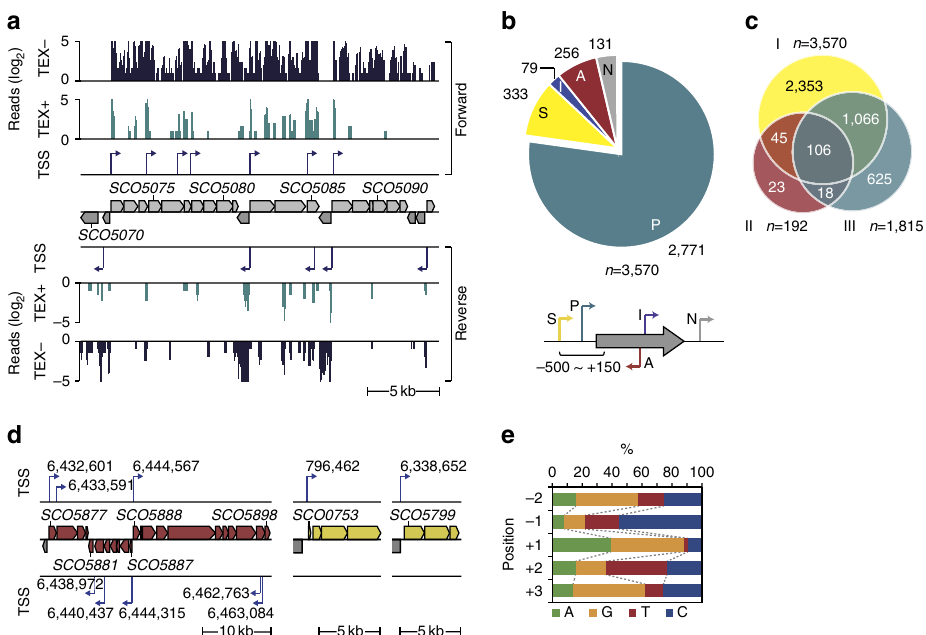
Figure 1 | Determination of the transcriptional architecture of the S. coelicolor genome. ( a ) Example of a dRNA-seq profile mapped onto the S. coelicolor genome. For TSS determination, total RNA samples from 44 growth conditions were pooled and two sequencing libraries were constructed, one from TEX-treated (TEX þ ) and the other from untreated total RNA (TEX (cid:2) ); TEX, terminator-5 0 -phosphate-dependent exonuclease. The criteria for assigning TSS are detailed in the Methods. ( b ) A total of 3,570 TSSs were identified and classified according to their positions relative to adjacent open reading frames (ORFs). TSSs located from 500bp upstream to 150bp downstream of the respective annotated start codon of each ORF were classified as the primary (P) or secondary (S). TSSs located within an annotated ORF or on the opposite strand were classified as internal (I) or antisense (A), respectively. TSSs not included in any of these categories were classified as intergenic (N). ( c ) Mapped TSSs in relation to those reported from previous studies. I, this study; II, ref. 16.; III, ref. 18. ( d ) TSSs associated with secondary metabolic gene clusters; prodiginine (left), bacteriocin (middle) and siderophore (right). ( e ) Proportion of each nucleotide at TSS ( þ 1) and 2 nt upstream and downstream of the